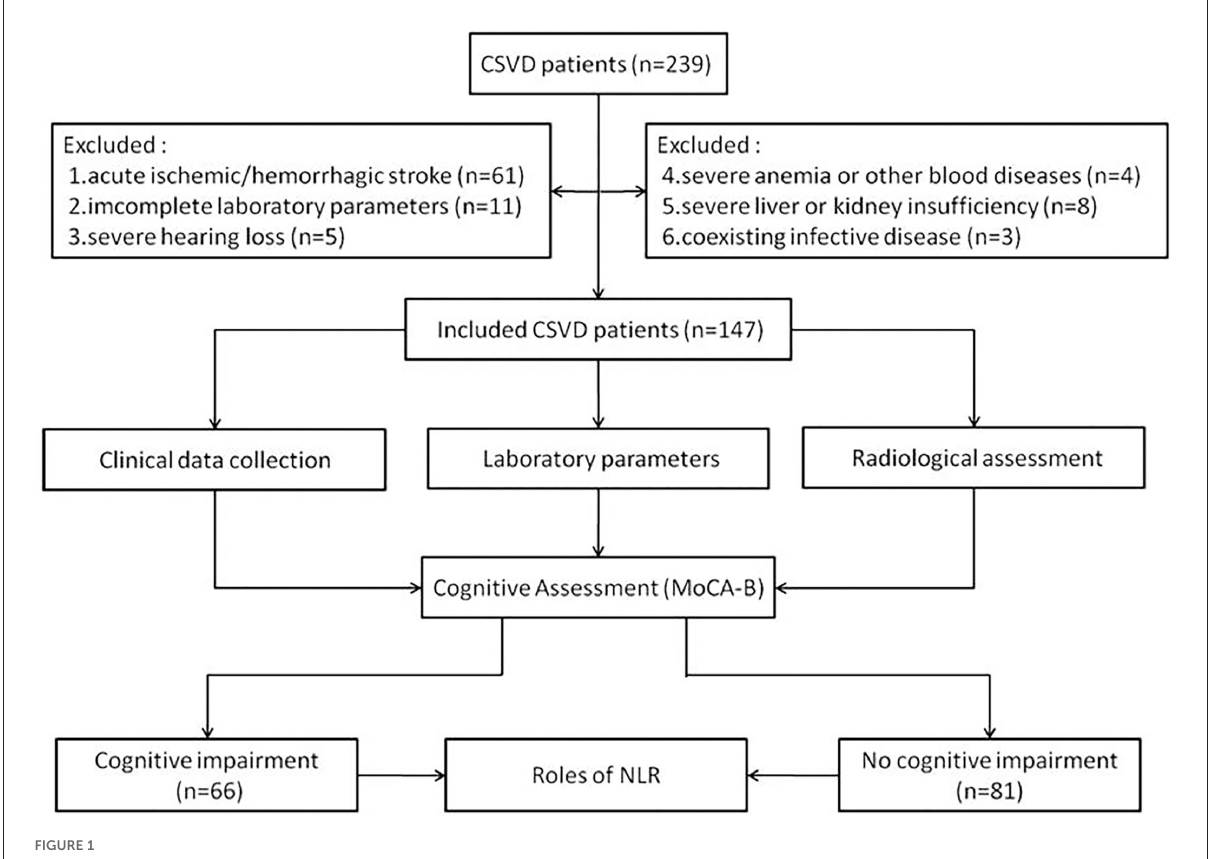
FIGURE1 The study flow